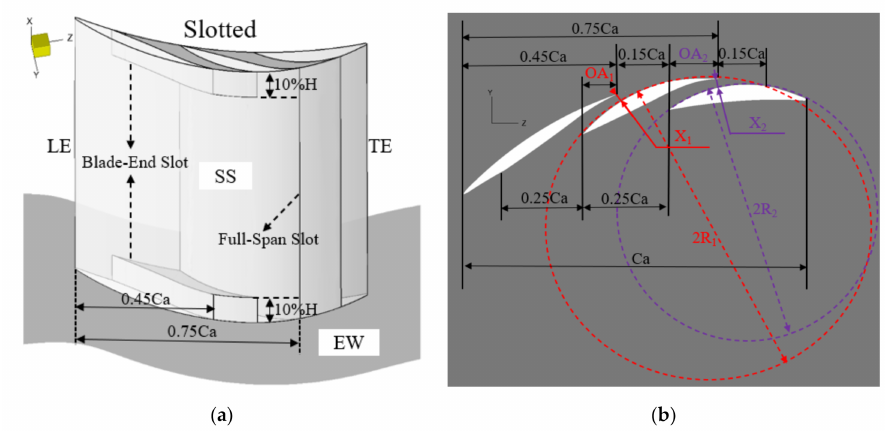
Figure 2. Combined slotted cascade: ( a ) overall combined slotted configuration ( b ) slot design parameters. The design parameters of the full-span slot and blade-end slot are shown in Figure